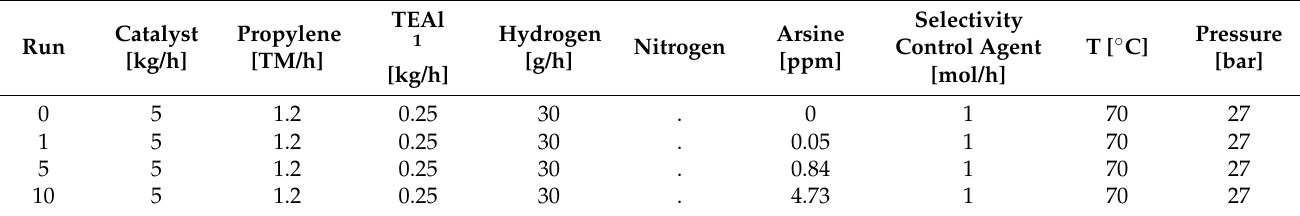
Figure 1. Diagram of the polymerization process and sampling points. Table 1. Reagents for